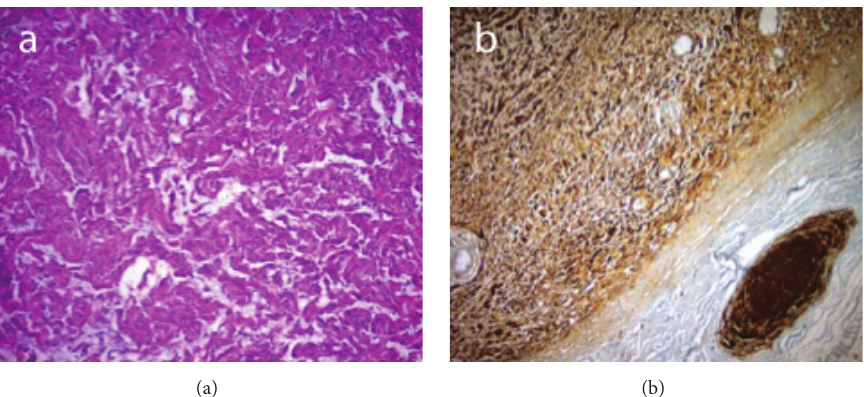
Figure 3: (a) Lesion was forming wavy fiber structures in edematous stroma in hypocellular areas. (b) Lesion had positive reaction with S-100 in immunohistochemical examination (a: Hematoxylin-Eosin X200, b: BSA-DAB